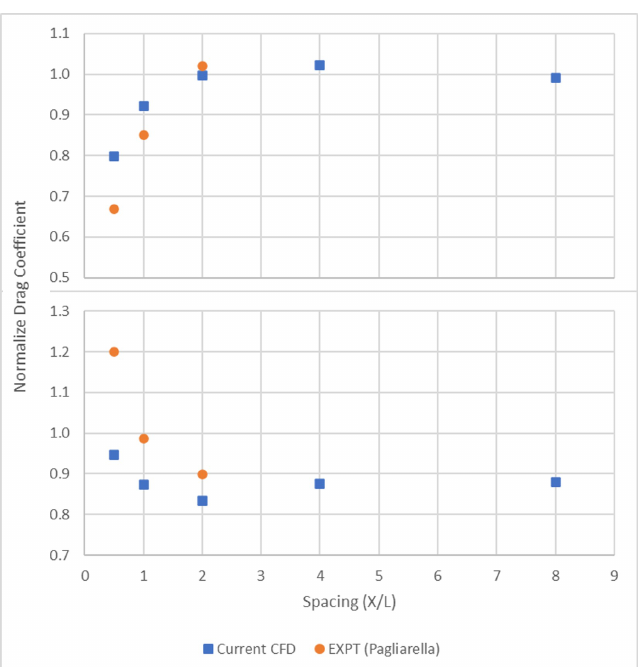
Figure 16. Drag Coefficient Variations Between the Current Work and Experimental [12]. Top-Leading and Bottom-Trailing.